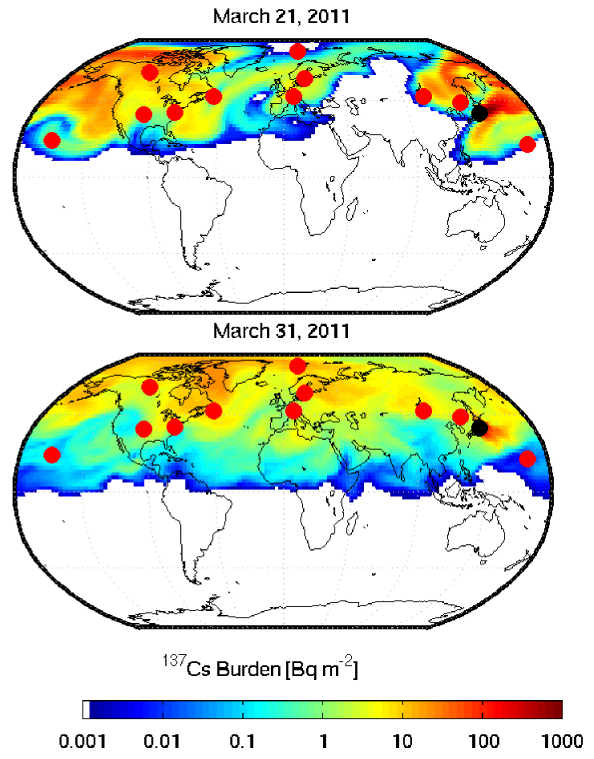
Fig. 1. Geographic distribution of 137 Cs burden on 21 March 2011 and 31 March 2011 for the control simulation (CTL) of the GEOS- Chem model using the emissions of Stohl et al. (2012). The acci- dent site is indicated by a black dot and Comprehensive Nuclear Test-Ban Treaty Organization (CTBTO) measurements sites are in- dicated by red